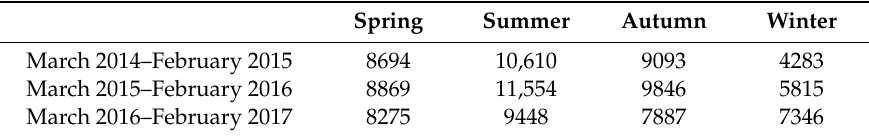
Table 3. Average number of tourists during each season.